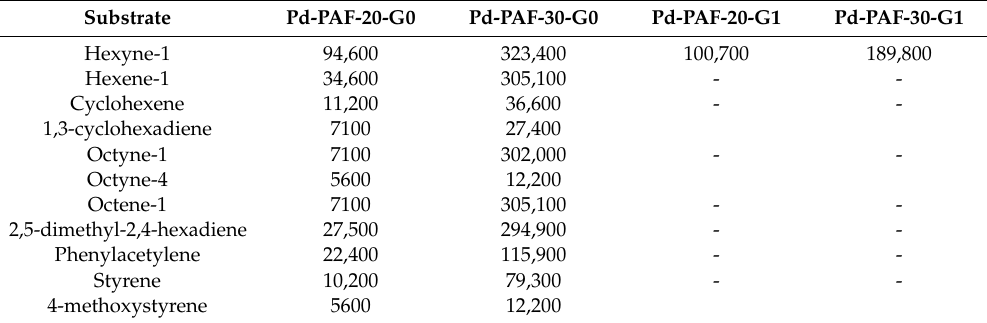
Table 7. Specific activity of synthesized